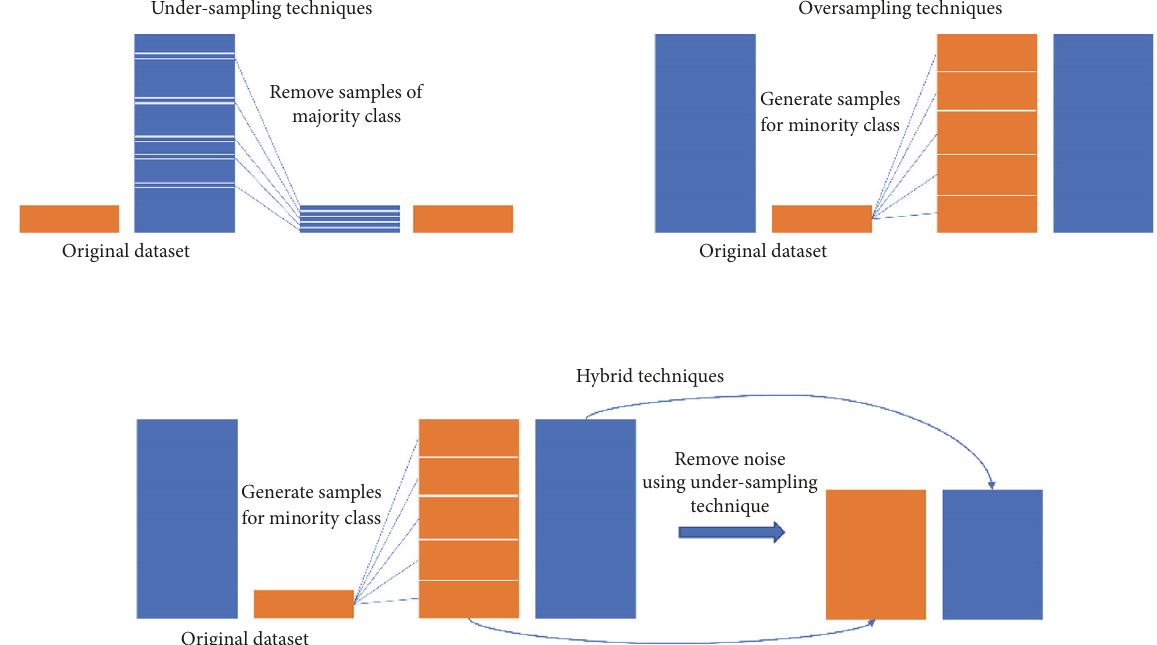
Figure 1: The illustration of oversampling, undersampling, and hybrids